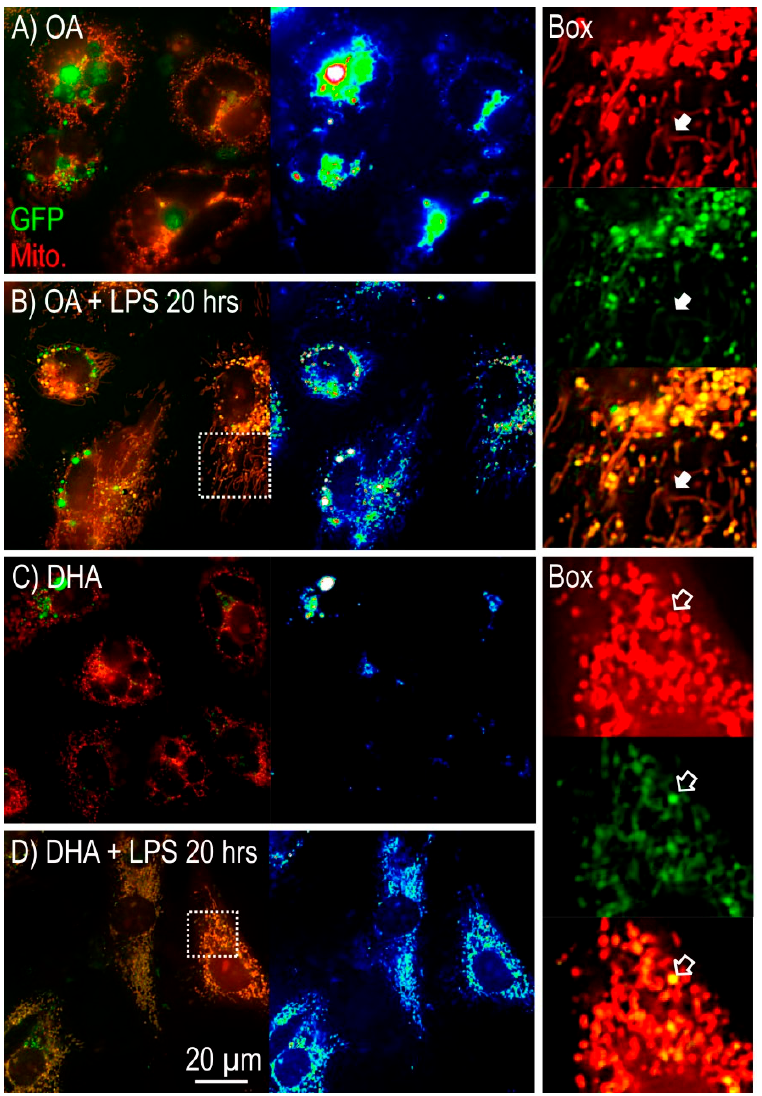
Figure 4. Imaging of mitochondrial morphology in mature Atlantic salmon adipocytes in vitro incubated with oleic acid (OA) ( A ) or docosahexaenoic acid (DHA) ( C ) for 6 days. Thereafter, the OA group ( B ) and the DHA group ( D ) were exposed to lipopolysaccharide (LPS) for 20 h. Mitochondria were visualized using MitoTracker (red) and a mitochondrial targeting SOD2-GFP construct (green). The panel on the right shows the area highlighted in the white dotted box for ( B , D ), showing the red channel, the green channel, and the merged image (colocalization shown in orange/yellow). Solid arrows point to fragmented mitochondria and open arrows point to round mitochondria.